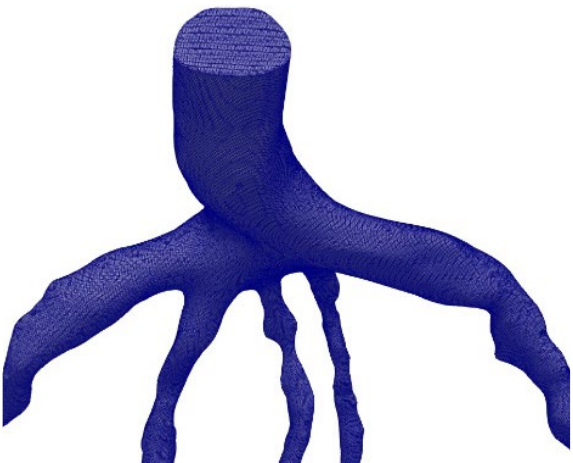
( b ) Figure 8. ( a ) Inlet boundary conditions: steady-state velocity waveform of left main coronary blood flow (adapted from [22]) and sinus flow: u(t) = 0.184 m/s − 0.02432 m/s*cos(2π*t) - 0.09822m/s*sin(2π*t) . ( b ) Inlet boundary conditions: normalized steady-state pressure and normal- ized transient waveform pressure. The convergence criteria were evaluated at the end of each iteration with Equation